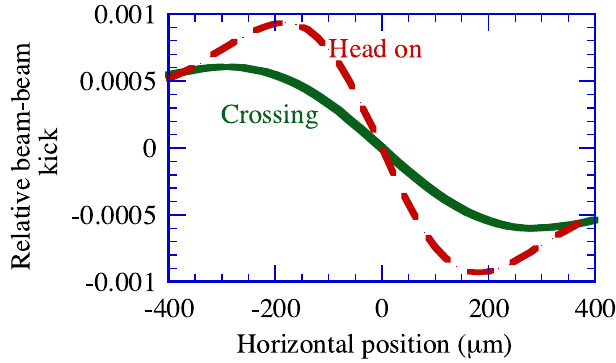
FIG. 1. (Color) Relative beam-beam kick as a function of the horizontal position shift at the IP; the dashed red line indicates the relative beam-beam kick in the case of a head-on collision, and the solid green line indicates the relative beam-beam kick in the case of a horizontal crossing angle of 22 mrad under identical beam